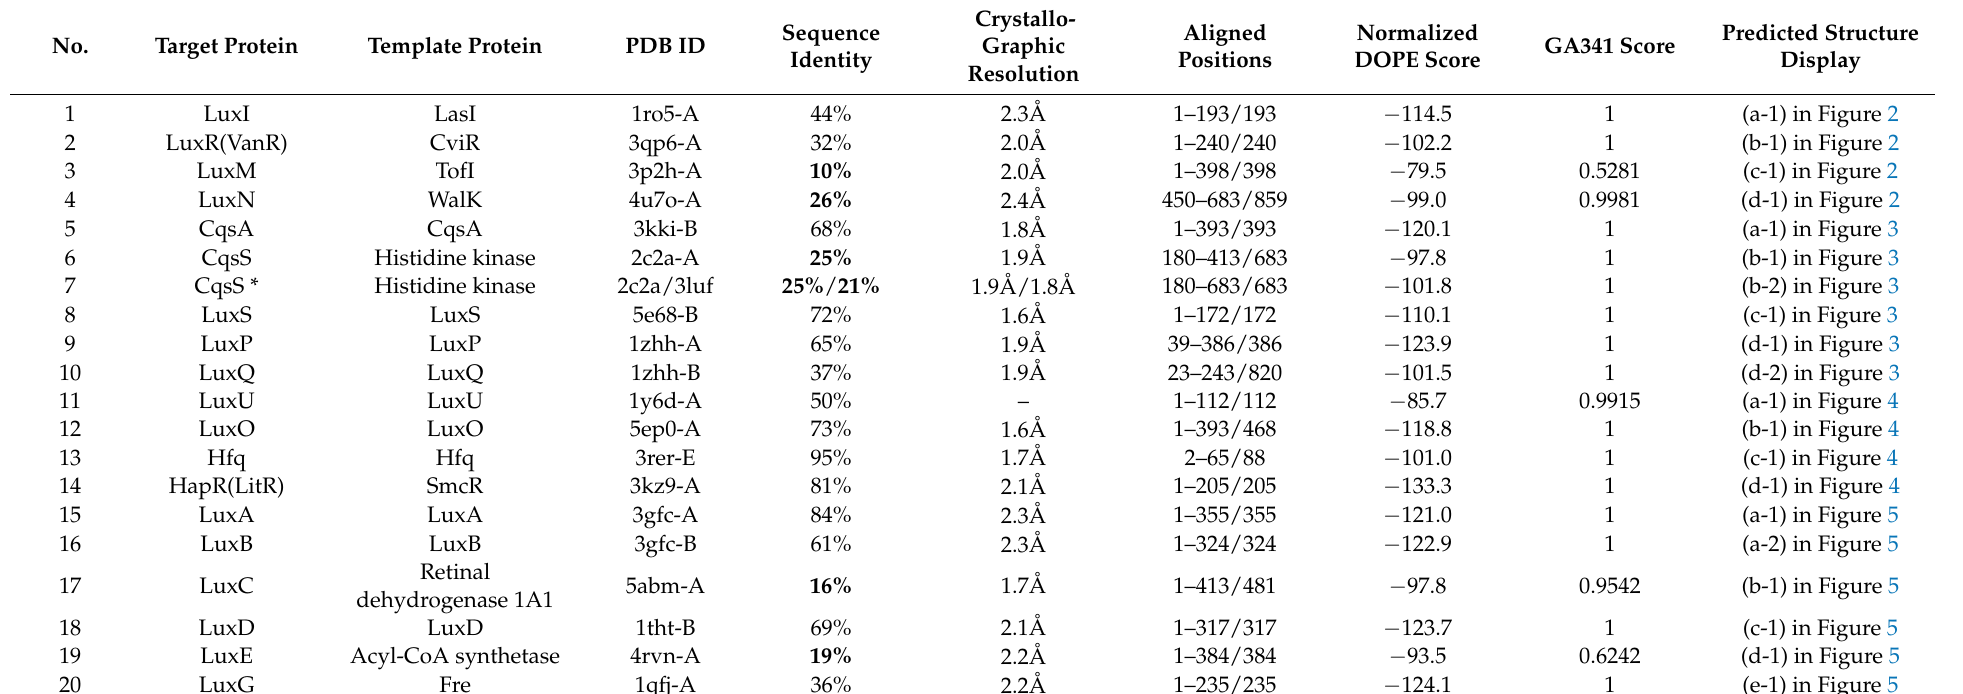
Table 1. Modeling of protein monomers in QS pathway of